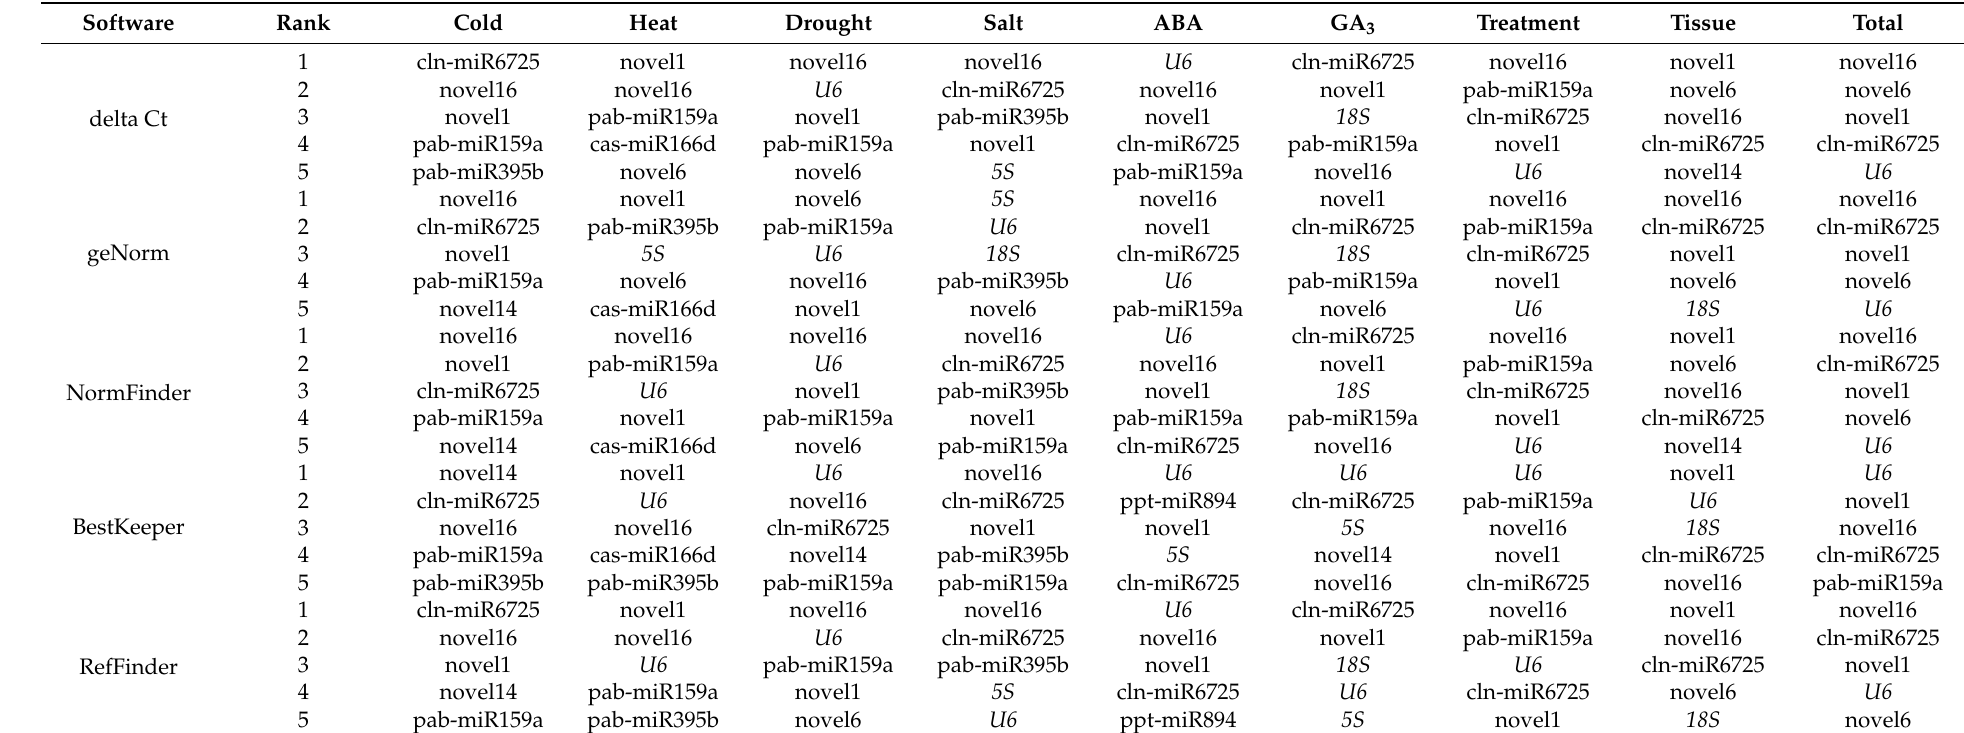
Table 3. Top five genes ranked by various